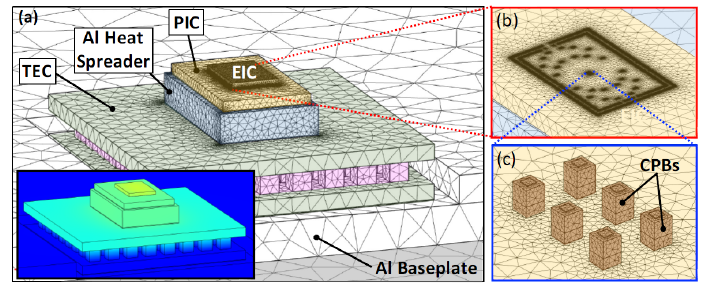
Figure 16. COMSOL thermal simulations of the EIC and PIC in the FP7 ‐ FABULOUS ONU; ( a – c ) For accurate convergent models, the simulation mesh must span from the 10 cm ‐ scale of the full module (including TEC and baseplate) to the 10 μ m ‐ scale of the CPB interconnects. The results of these simulations can be validated against thermal ‐ imaging, and used to test new designs for better cooling of the EIC and PIC in the photonic module.